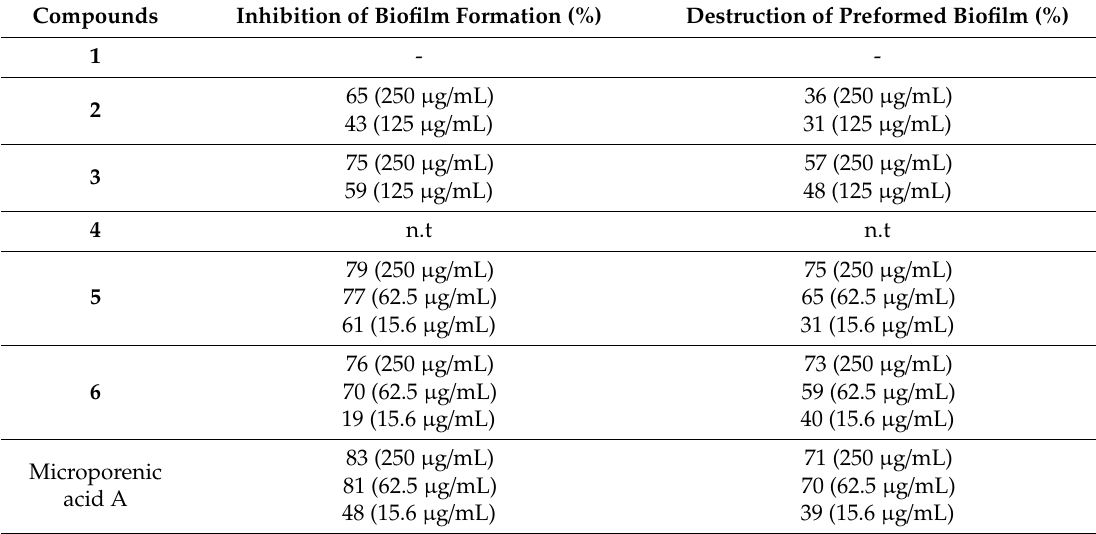
Table 4. Inhibition of biofilm and destruction of preformed biofilm in Staphylococcus aureus by compounds 1 – 3 , 5 , 6 .